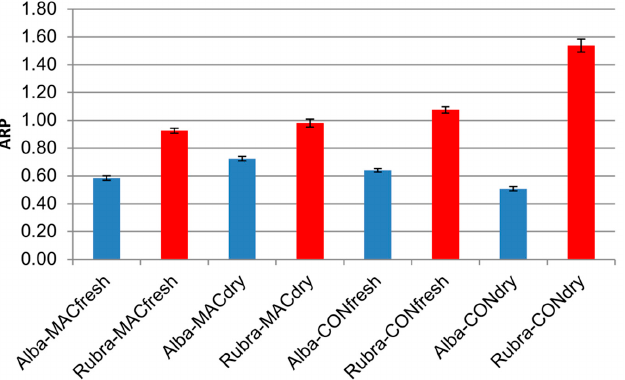
Figure 6. ARP values of the liqueurs from fresh and dry petals of Rosa rugosa cv. Alba and Rubra after maceration or conventional extraction.